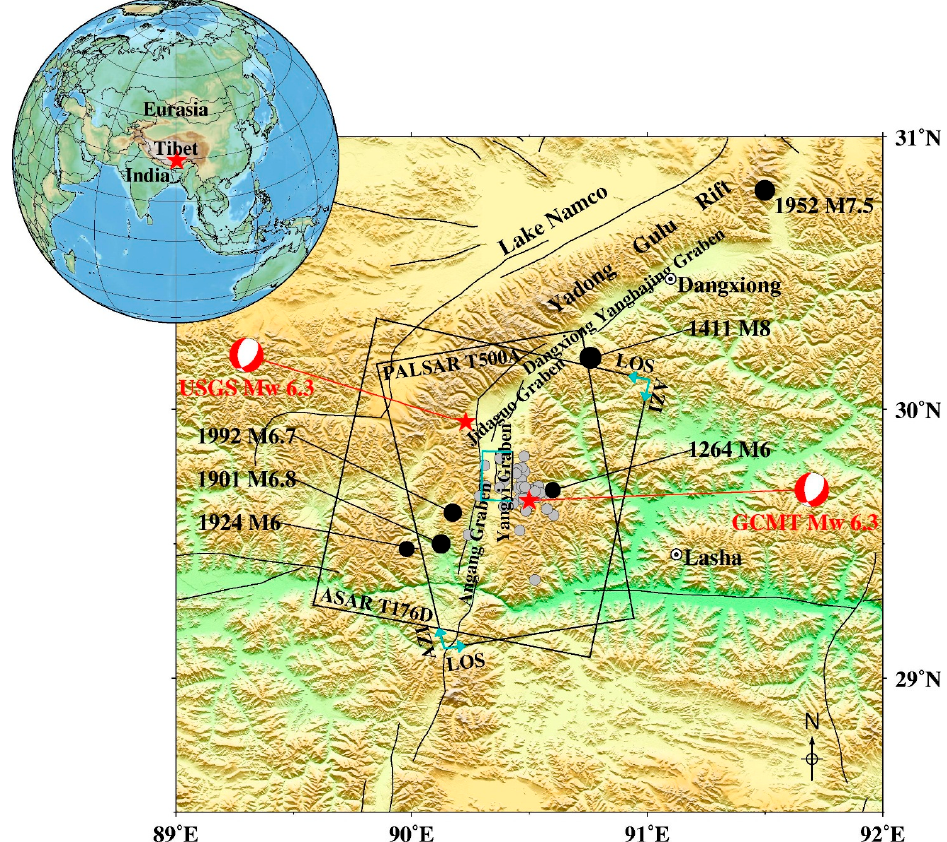
Figure 1. Tectonic setting of the 6 October 2008 Dangxiong M W 6.3 earthquake. Location of study area on the globe, and map of study area with major tectonic faults [35]. Black rectangles mark the areas covered by the Envisat ASAR (Descending Track 176) and ALOS PALSAR SAR data (Ascending Track 500); AZI and LOS refer to satellite azimuth and look direction, respectively. Light blue box denotes the fault surface projection on the ground with the black line as its top. Thin black lines denote the Quaternary active faults [36]. Red beach balls represent the earthquake source mechanisms (from USGS and GCMT). Gray solid circles indicate the location of aftershocks. Black solid circles with the time and magnitude indicate historic earthquake events